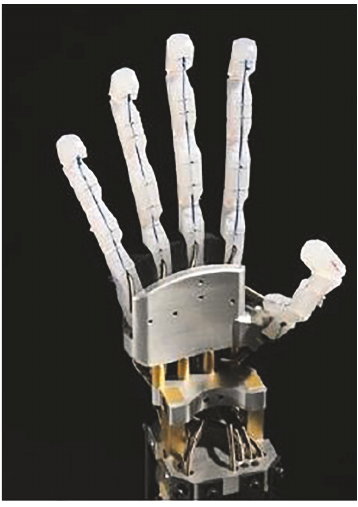
Figure 3: Hand gesture robot